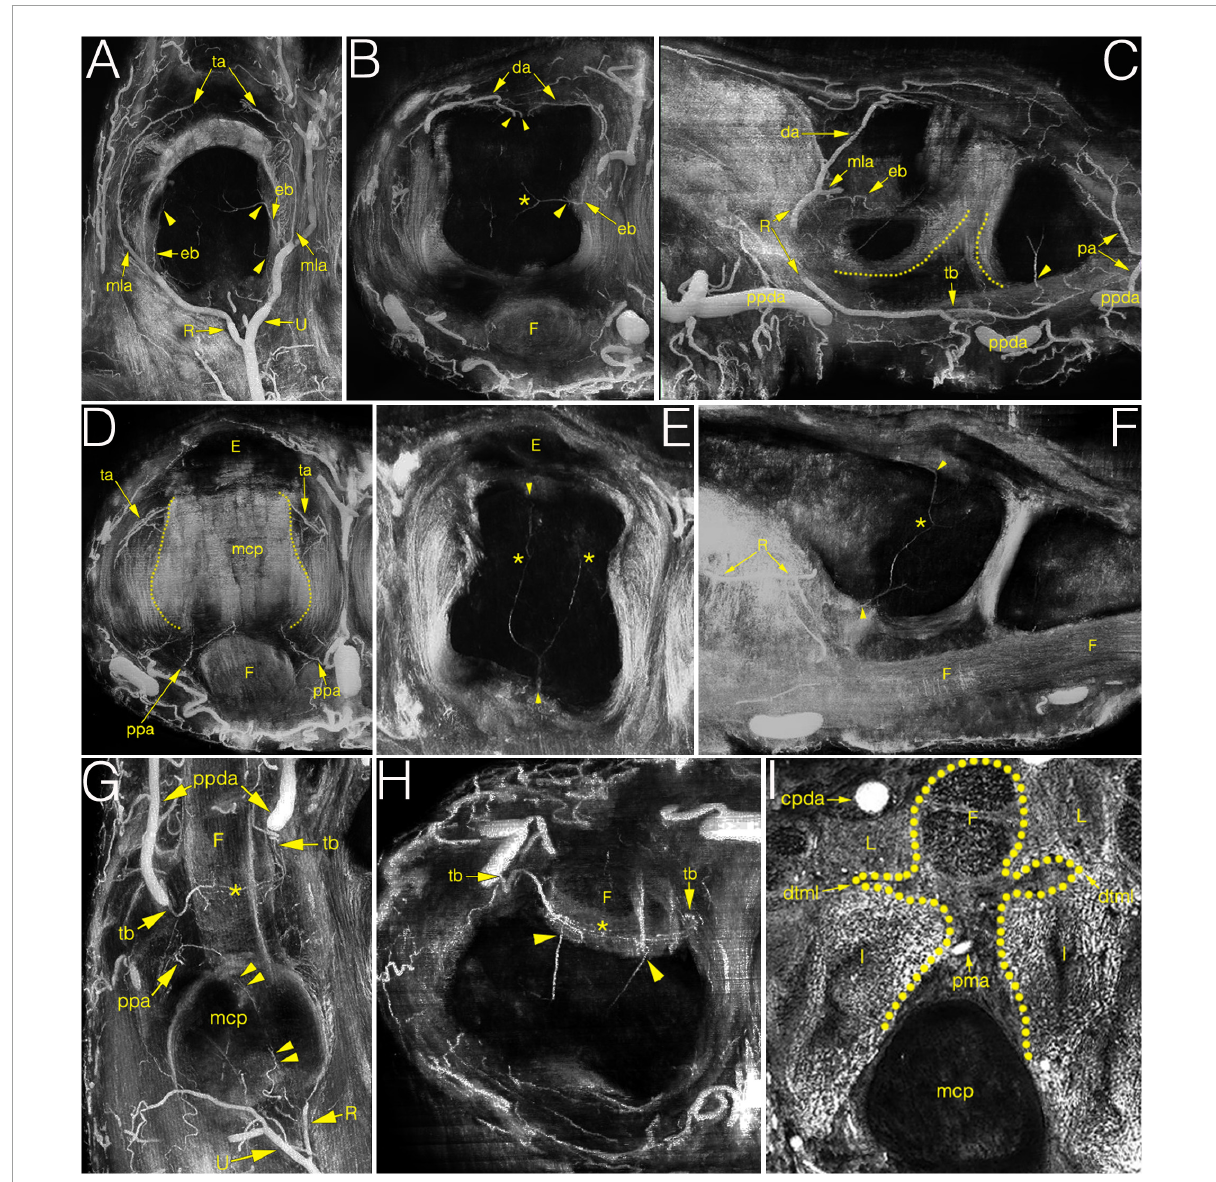
FIGURE4 Multiplanar (MIP) image reconstructions on cryosectioned specimens demonstrating the relationship between arteries and joint structures. (A–C) main supplying branches on coronal, axial and sagittal plane, respectively. Note on C the elongated anastomosis between the R-branch and the tenosynovial branch. Dotted lines indicate the palmar articular surfaces of bones; (D) palmar plate artery and the triangular arcade on the axial plane. Dotted lines indicate the lateral borders of metacarpal head; (E,F) blood supply of the metacarpal head on the axial and sagittal plane. Note the anastomosis between the dorsal, palmar and lateral enosseal arteries, respectively. Compare with panel (B) . (G,H) origin and course of the tenosynovial trunk on the coronal and axial plane. Note the anastomosis between the two sides within the flexor tendon. (I) homuncule shaped (dotted line) soft tissue complex in the center with the palmar metacarpal artery on the axial plane. *, anastomosis; cpda, common palmar digital artery; da, dorsal arcade; dtml, deep transverse metacarpal ligament; eb, enthesial branch; E, extensor tendon; F, flexor tendon; I, interosseous muscle; L, lumbrical muscle; mcp, metacarpal; mla, main lateral artery; pa, phalangeal arcade; pma, palmar metacarpal artery; ppa, palmar plate artery; ppda, proper palmar digital artery; R, R-branch; ta, triangular arcade; tb, tenosynovial trunk; U, U-branch; arrowheads, entry point of enosseal arteries; doubled arrowheads, supplying artery from the R-branch to the flexor